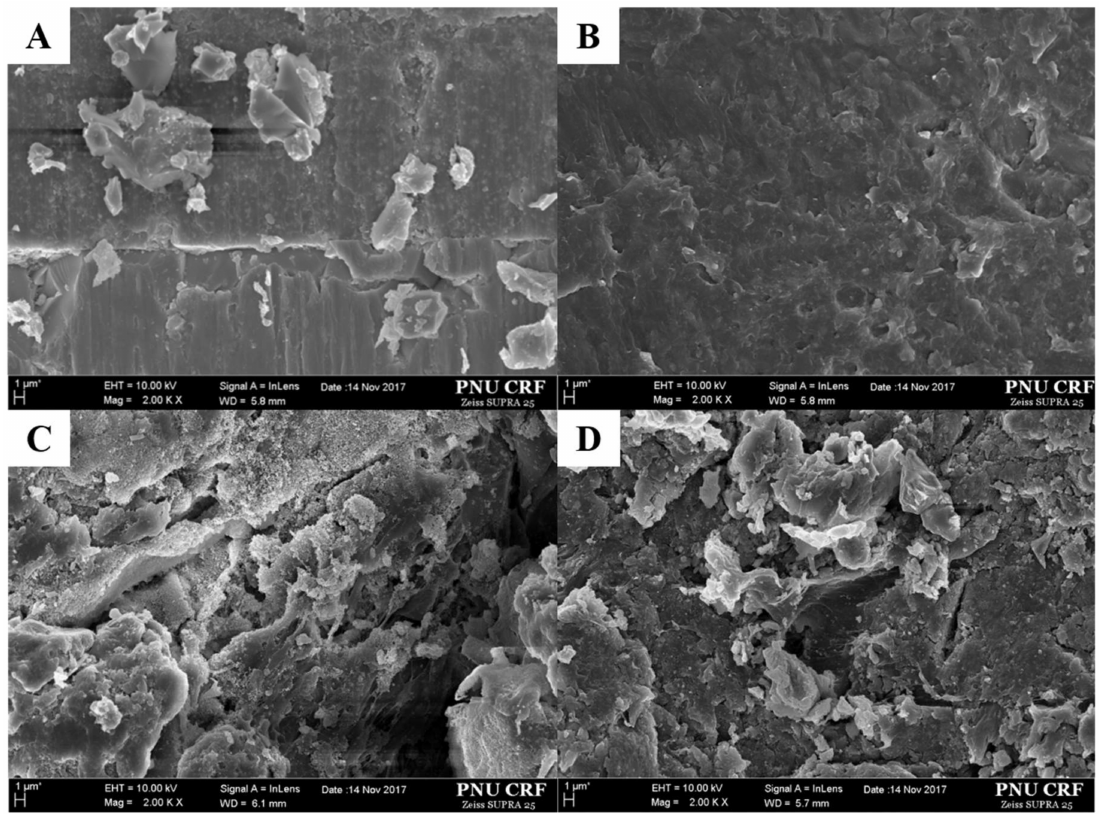
Figure 5. The scanning electron microscopy (SEM) images of different surface treatments at a magnification of 2000 × ; ( A ) the F1 group: 35% Phosphoric etching; ( B ) the P1 group: no treatment; ( C ) the P2 and P4 groups: alumina particle abrasion; ( D ) the P3 group: silica-coated alumina particle abrasion): in the PEKK post with a surface that was sandblasted with 110 µ m aluminum oxide and then blasted with a silica-modified aluminum oxide, irregular particles and a roughness were